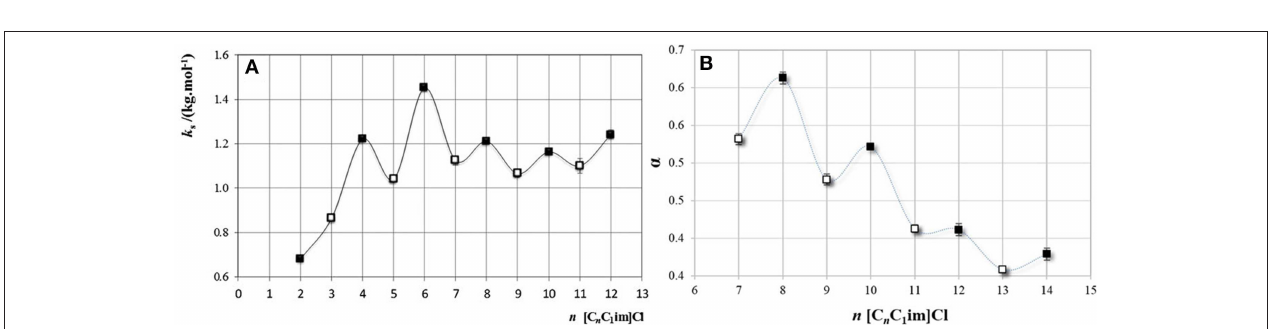
FIGURE 8 | (A) Experimental densities of [P 888 n ]Cl ionic liquids at 303.15K, where n = 3,5,7, and 9 (green circles), n = 4,6,8,10,12, and 14 (blue triangles). (Reprinted from Adamová et al., 2011 with permission from Royal Society of Chemistry) (B) See-saw, even/odd alternation effect in the form of deviations (residuals) between experimental and fitted molar volume (V) data as a function of n , at four different temperatures. (Reprinted from Adamová et al., 2011 with permission from Royal Society of Chemistry).